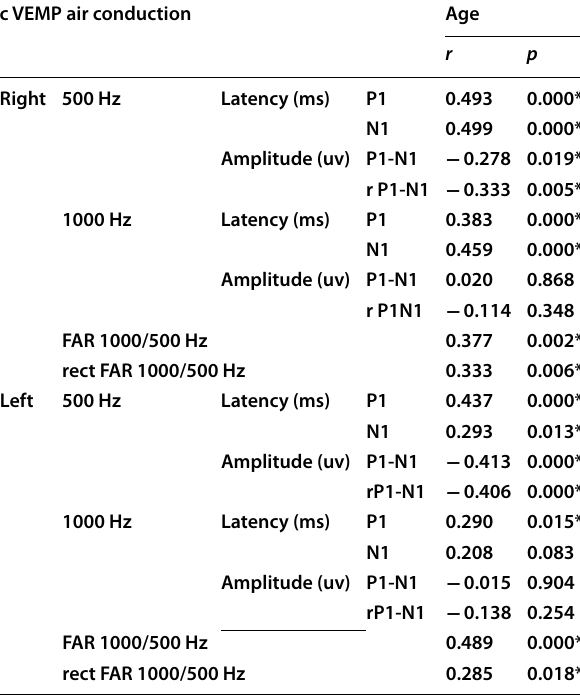
Table 6 Correlation coefficient ( r ) between age and bone conduction cVEMP parameters at 500 and 1000 Hz in the right and left ears of the study